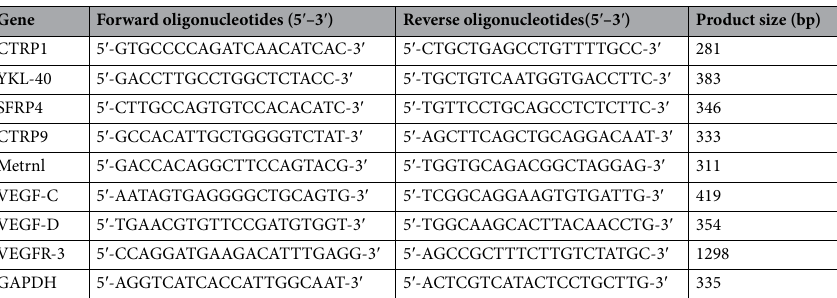
Table 1. Primers used for real-time quantitative PCR. CTRP, complement-Clq TNF-related protein; YKL-40, Chitinase-3-like protein 1; SFRP4, secreted frizzled-related protein 4; Metrnl, Meteorin-like; VEGF, vascular endothelial growth factor; VEGFR-3, vascular endothelial growth factor receptor